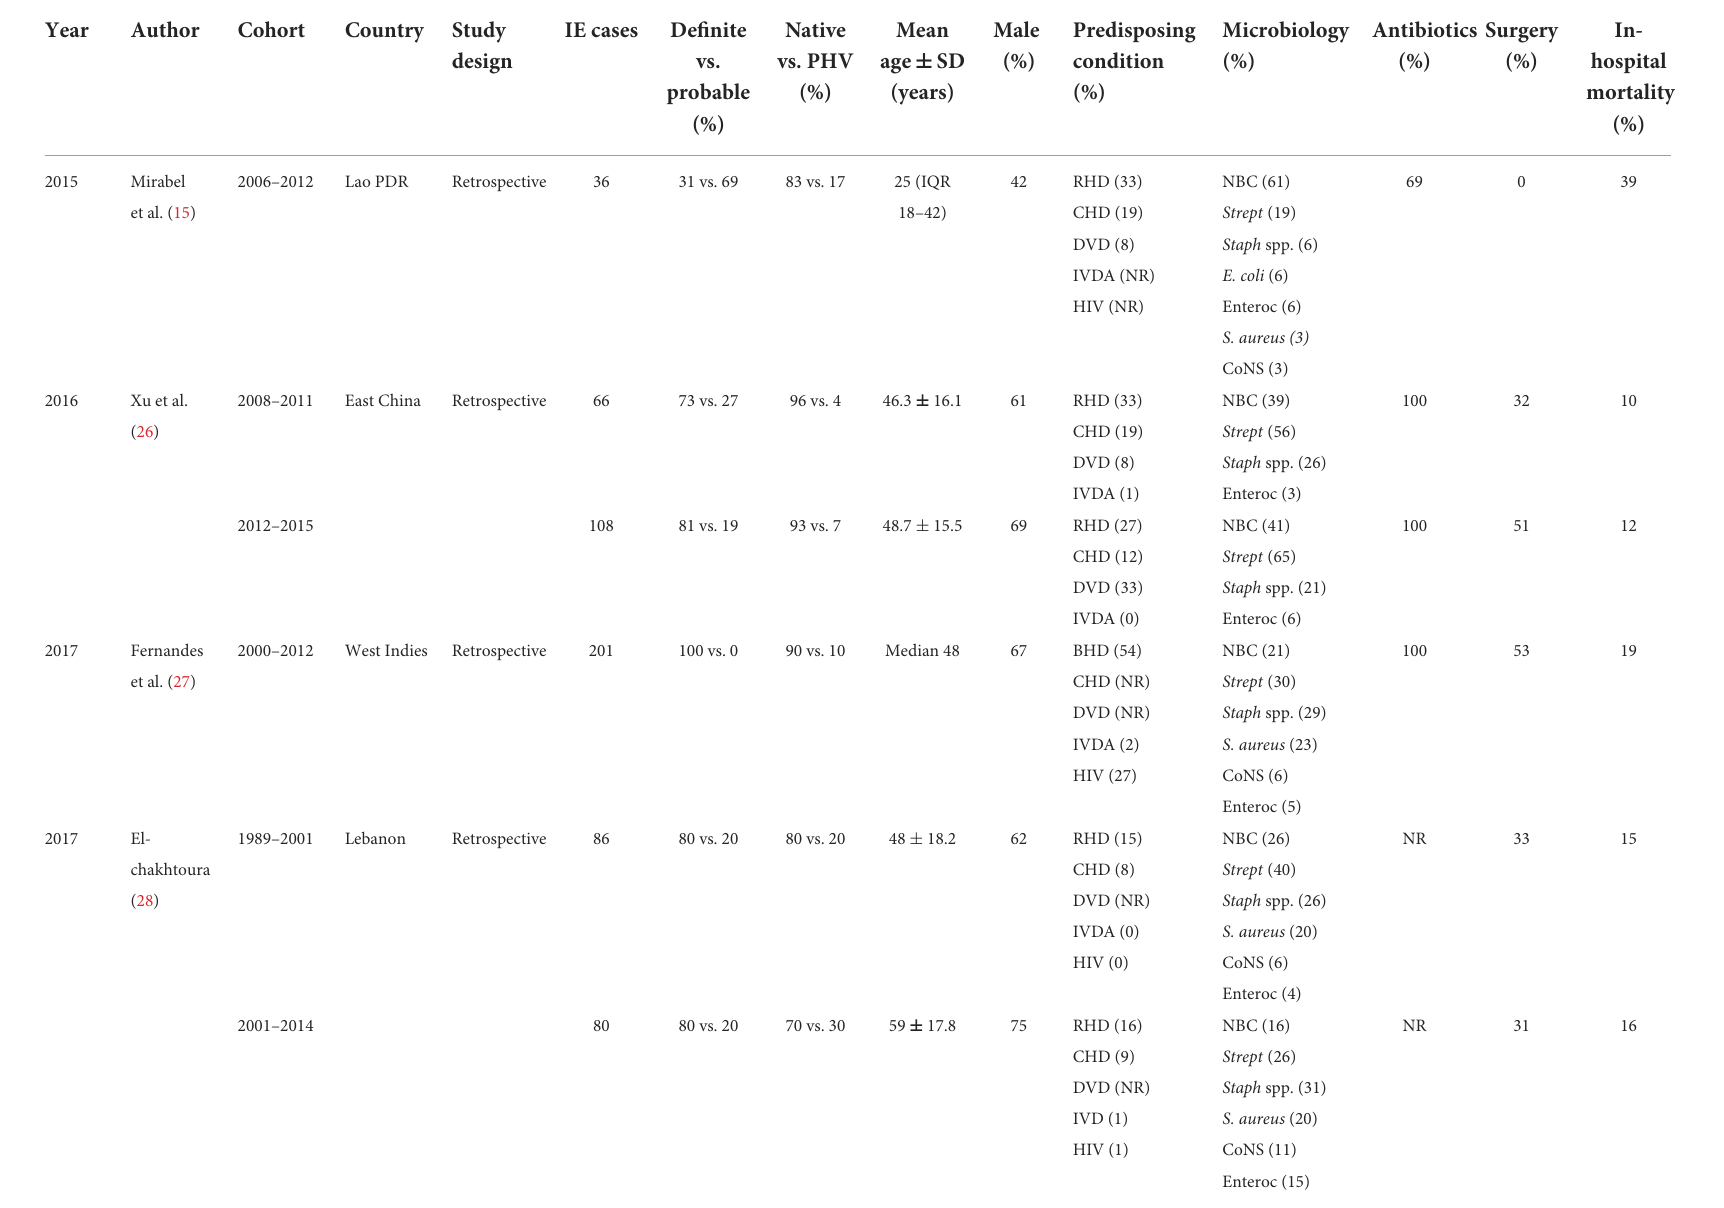
TABLE 2 Characteristics of the study population of group 2, publication ≥ 2015 to